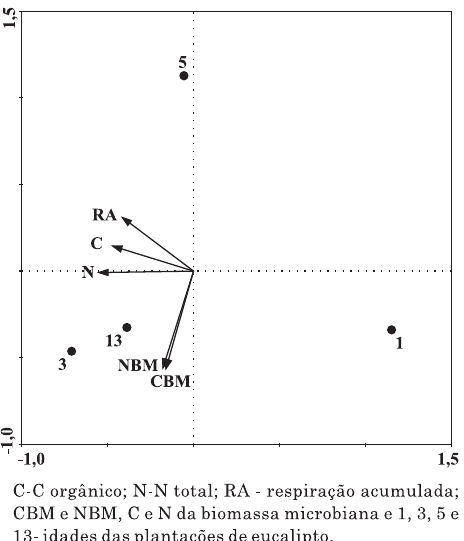
Figura 1. Diagrama de ordenação produzido pela análise de componentes principais dos atributos do